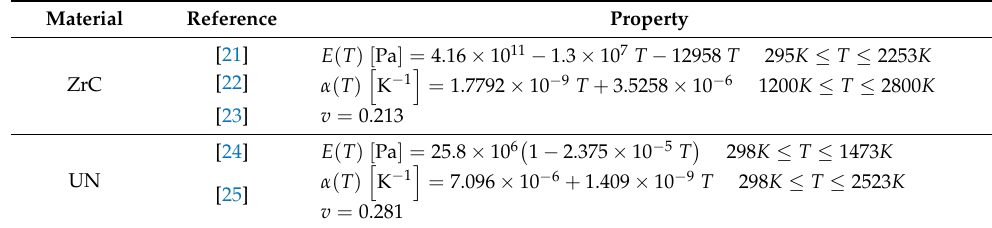
Table 2. Temperature-dependent fuel material mechanical